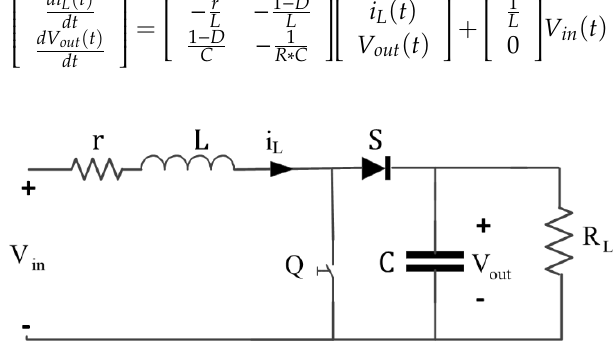
Figure 3. DC-DC boost power electronic convertor (PEC) diagram.